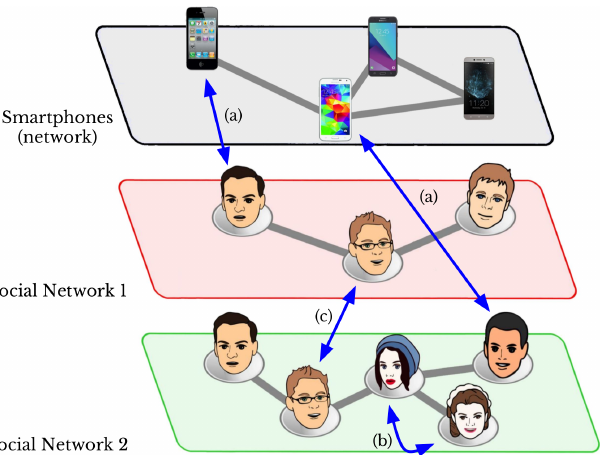
Figure 1. User-unaware watermarking’s three main tasks: profile attribution ( a ), intra-layer user profile linking ( b ), and inter-layer user profile linking ( c